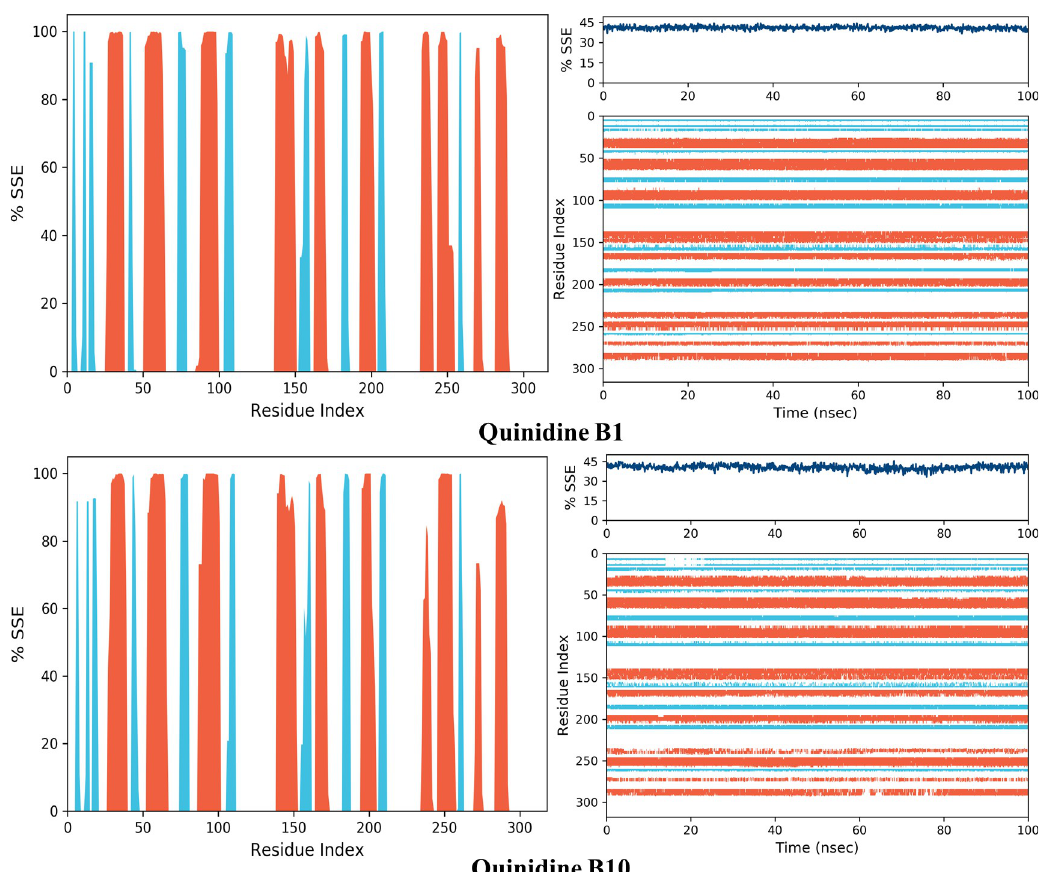
Fig 19. AKR1B1, AKR1B10 bound with quinine secondary structure element distribution by residue index. The colours red and blue represent alpha helices and beta strands, respectively.